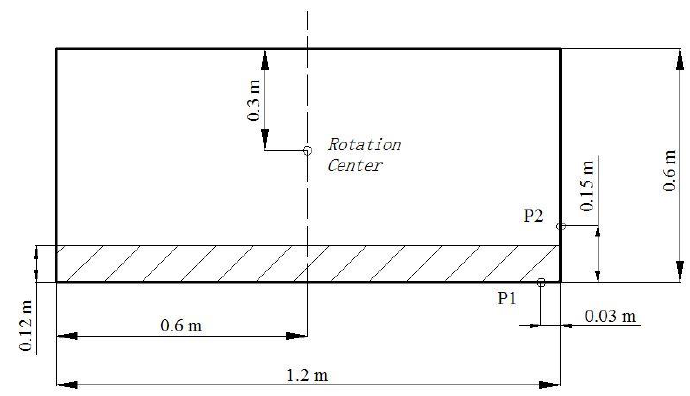
Figure 1. Sketch of sloshing tank without baffle following Liao and Hu [27].